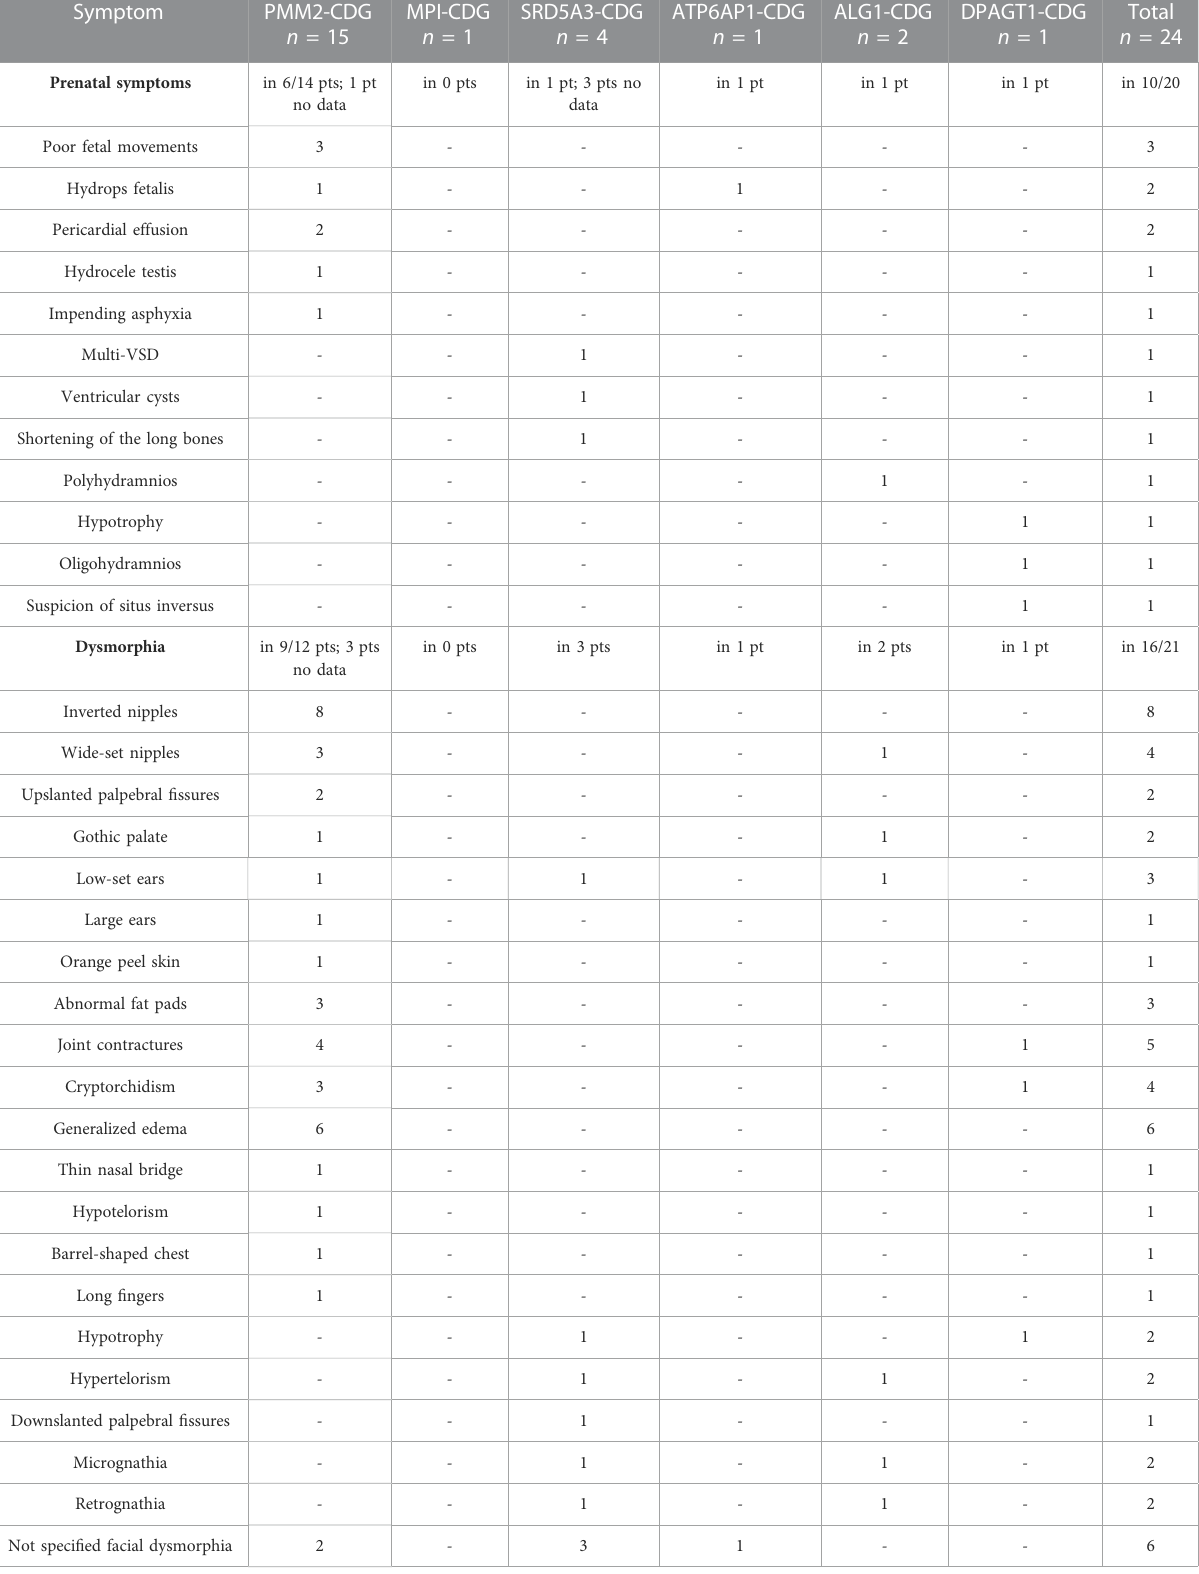
TABLE 1 Clinical symptoms found in different CDG